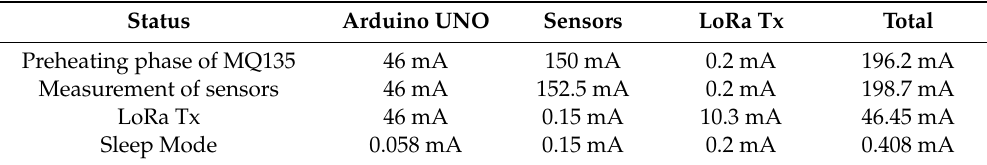
Table 5. Consumption for each